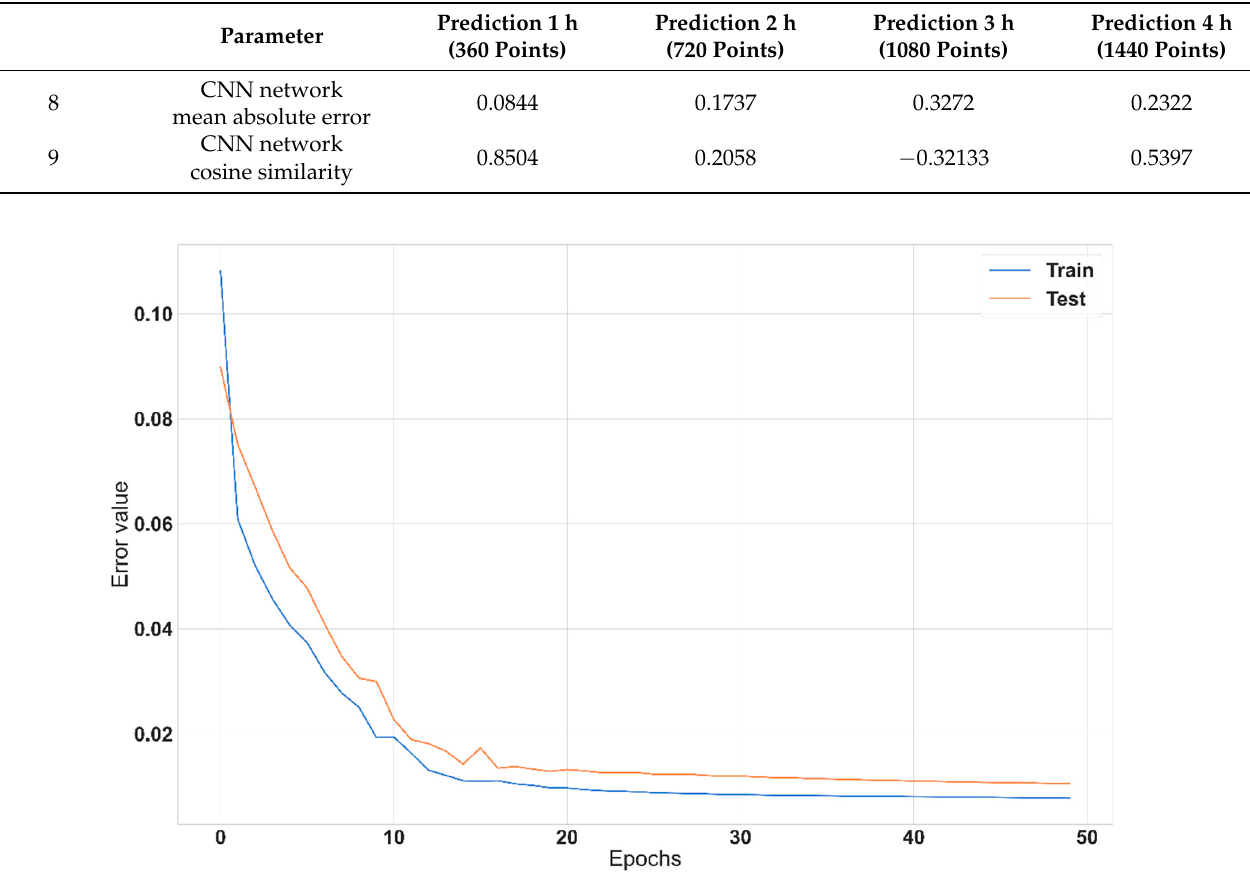
Energies 2022 , 15 , x FOR PEER REVIEW